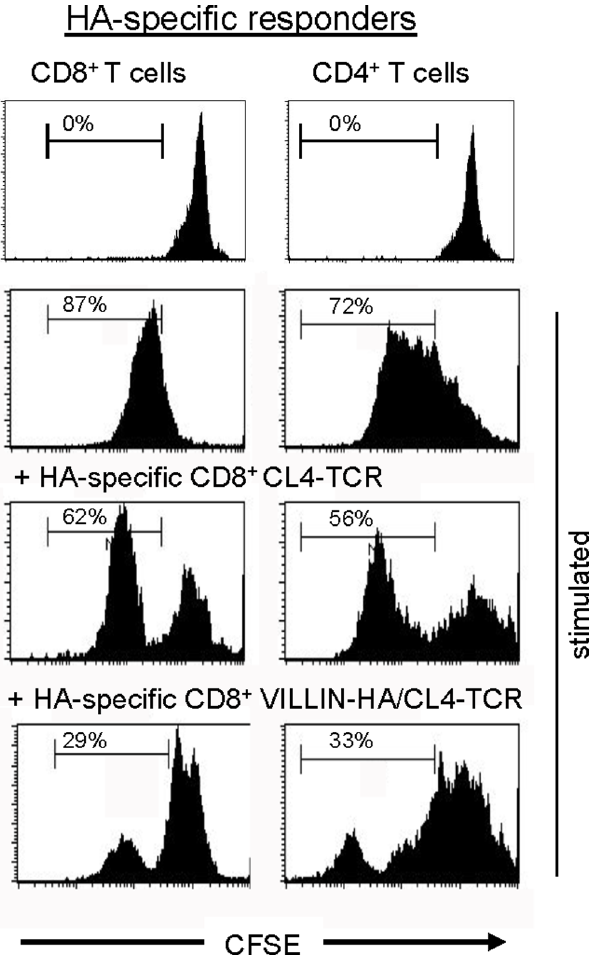
Figure 2. HA-specific CD8 + T cells from VILLIN-HA/CL4-TCR exhibit suppressive capacity. HA-specific CD8 + T cells were isolated from the MLN of CL4-TCR and VILLIN-HA/CL4-TCR transgenic mice by cell sorting and co-cultured with CFSE-labeled HA-specific CD4 + or CD8 + responder cells in the presence of the cognate peptide. Proliferation of responder cells was measured by loss of CFSE dye. Data shown are representative of three independent experiments.